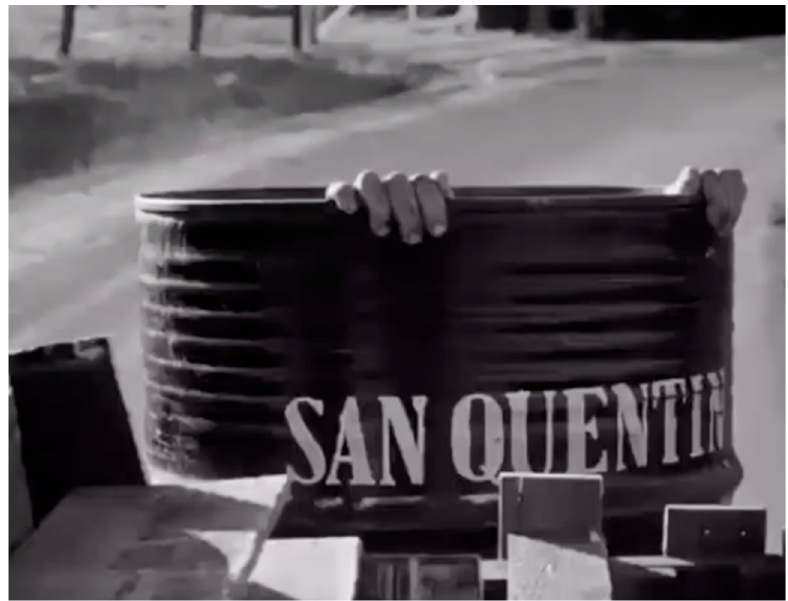
Figure 11. Image from Dark Passage (1947) [37].